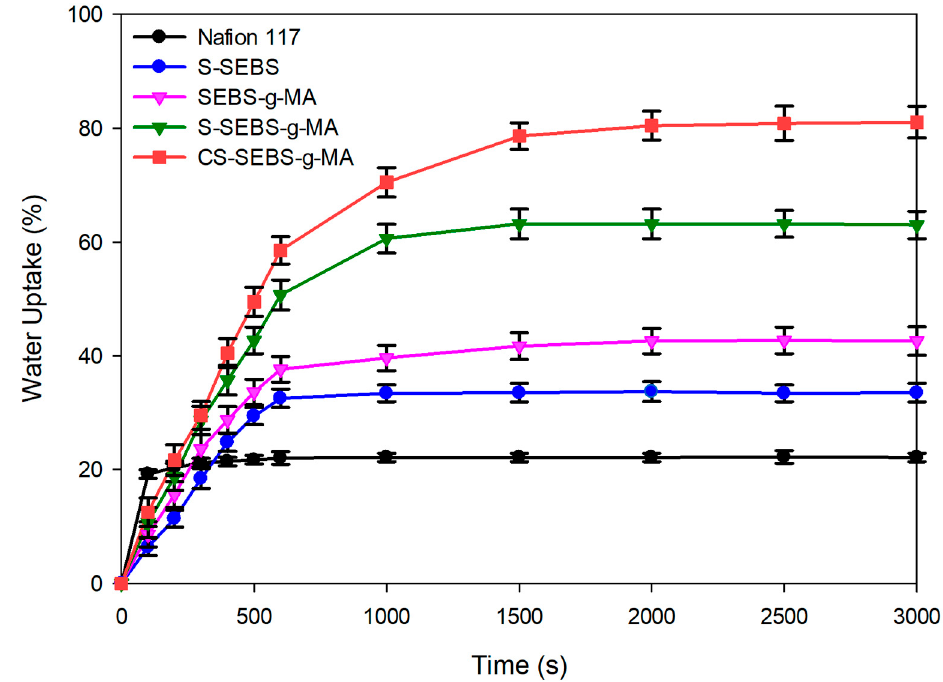
Figure 7. Water uptake of the Nafion 117, S-SEBS, SEBS-g-MA, S-SEBS-g-MA, and the crosslinked S-SEBS-g-MA membranes as a function of time. Water uptake data were recorded for at least five sample from each sample set.